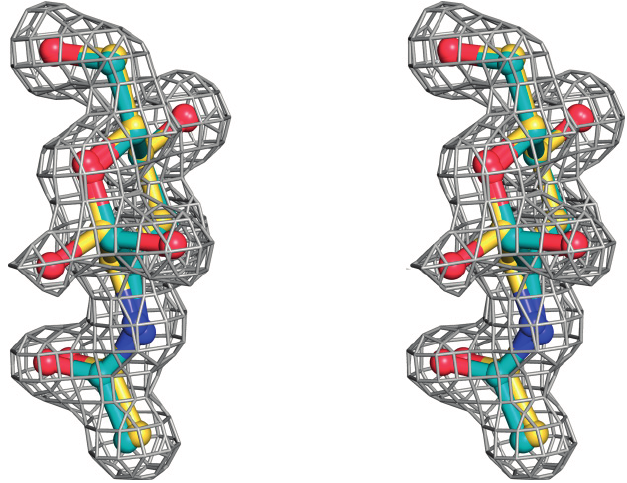
Figure 3. Stereoview of sigmaA 2|Fo|–|Fc| electron density map, contoured at the 1.0 σ level, for the N -acetyl β - D -glucosamine and N -acetyl α - D -glucosamine molecules bound at the secondary SSR1 carbohydrate-binding site before the incorporation of the carbohydrate ligand